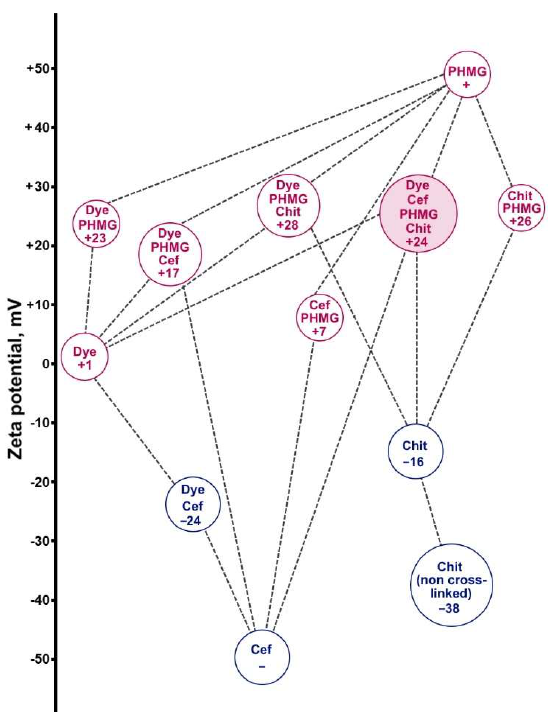
Figure 6. Zeta potentials of particles in the systems, containing maleated chitosan (Chit; all Chit-containing systems were cross-linked with glutaraldehyde, if not labeled otherwise); poly(hexamethyleneguanidine hydrochloride) (PHMG), ceftriaxone (Cef) and dye, in 7 mM phosphate buffer (pH 7.4). Concentration of components (polymers–by monomer unit): 1.4 mM Chit, 2.2 mM PHMG, 1.0 mM Cef, 2.8 μM dye. Soluble compounds, Cef and PHMG, are marked with “−” and “+”, respectively.